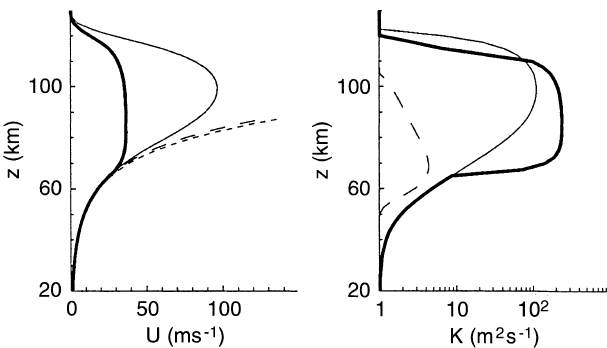
Fig. 1. Vertical profiles of the amplitude ( left ) and turbulent viscosity ( right ) calculated for the IGW harmonic with (cid:114) (cid:136) 10 (cid:255) 3 s (cid:255) 1 and c (cid:136) 30m s (cid:255) 1 propagated from tropospheric hydrodynamic source with s m (cid:136) 10 (cid:255) 4 m s (cid:255) 2 , z m (cid:136) 10km, and d (cid:136) 2km in isothermal windless atmosphere with T 0 (cid:136) 230K for the values of K (cid:136) 0 ( dotted lines ), K (cid:136) K 0 (cid:135) K nR ( thin solid lines ), K (cid:136) K 0 (cid:135) K nW ( dashed lines ), and K described by Eq. (23) in solid ( thick lines )